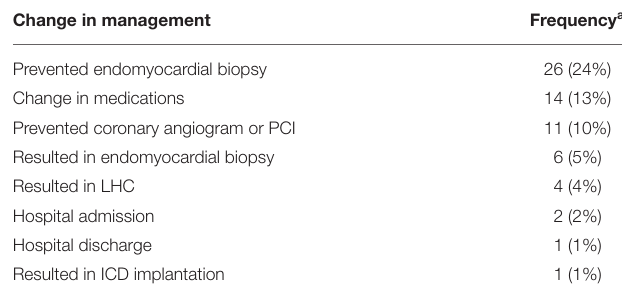
TABLE 3 | Final CMR diagnosis.